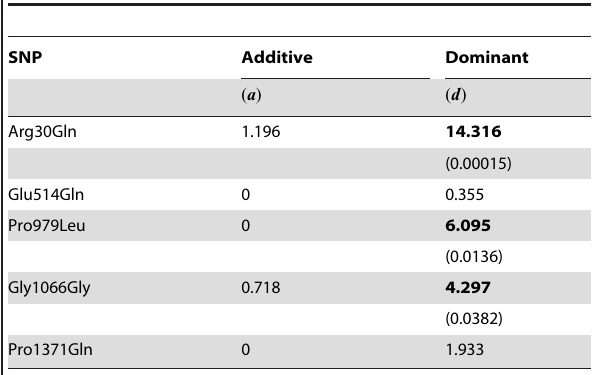
Table 6. The x 2 test statistics calculated to test the additive and dominant effects at each SNP genotyped from DLG5.